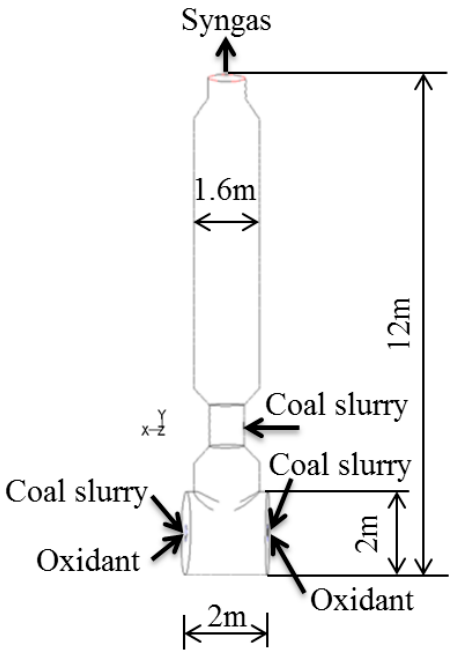
Figure 1. Schematic of the computational model of E-STR.